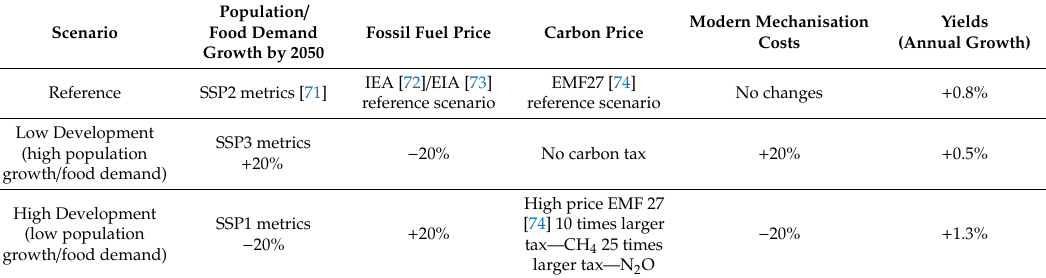
Table 11. Summary of analysed scenarios for Chinese